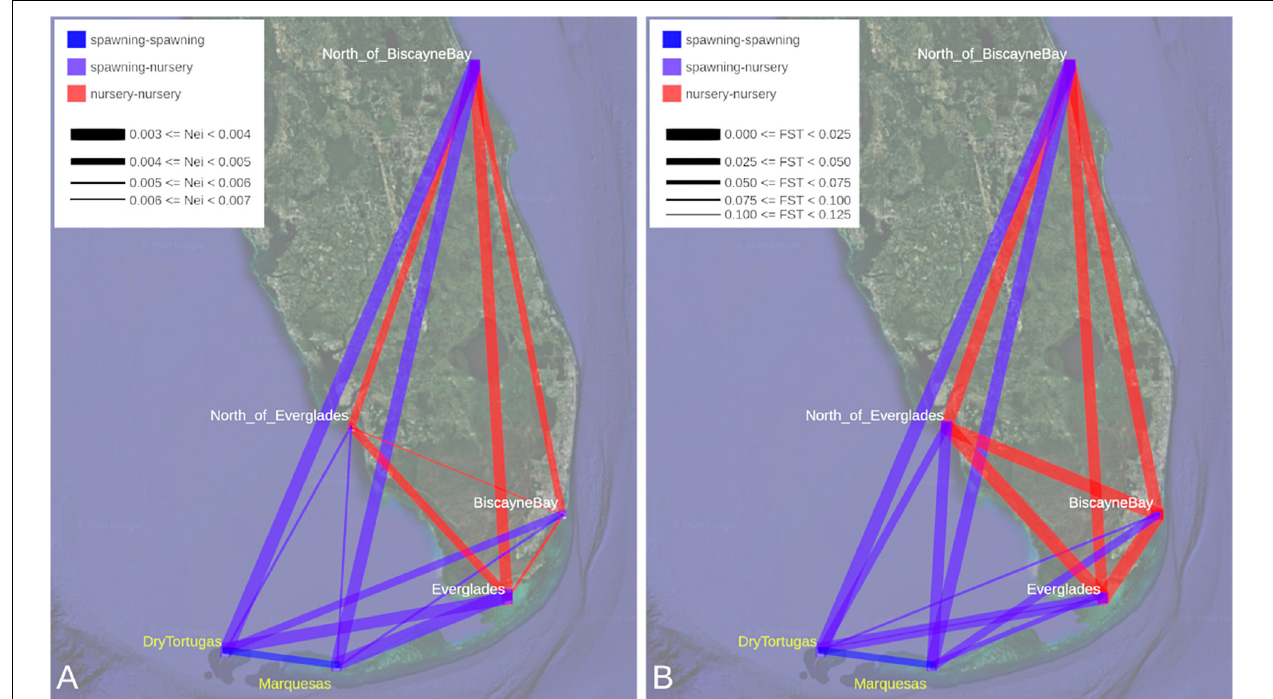
FIGURE 2 | (A) Nei’s unbiased distance values and (B) pairwise F ST values are depicted between all regions. Due to the small sample size of the SouthBiscayneBay region ( n = 3), samples from this region have been excluded from these analyses. Detailed results for each dataset are presented in Supplementary Tables 2, 3 (Nei’s and F ST , respectively) and distributions are plotted in Supplementary Figures 1, 2 (Nei’s and F ST , respectively). Line color indicates the type of region pair: nursery region to nursery region (red), nursery region to spawning region (purple), or spawning region to spawning region (blue). Line width indicates genetic distance with greater genetic distance or higher F ST illustrated with a narrower connecting line. Please note that these lines solely represent pairwise values, not movement of individual shrimp between regions. Spawning regions are labeled in yellow (Base map from Google Earth).